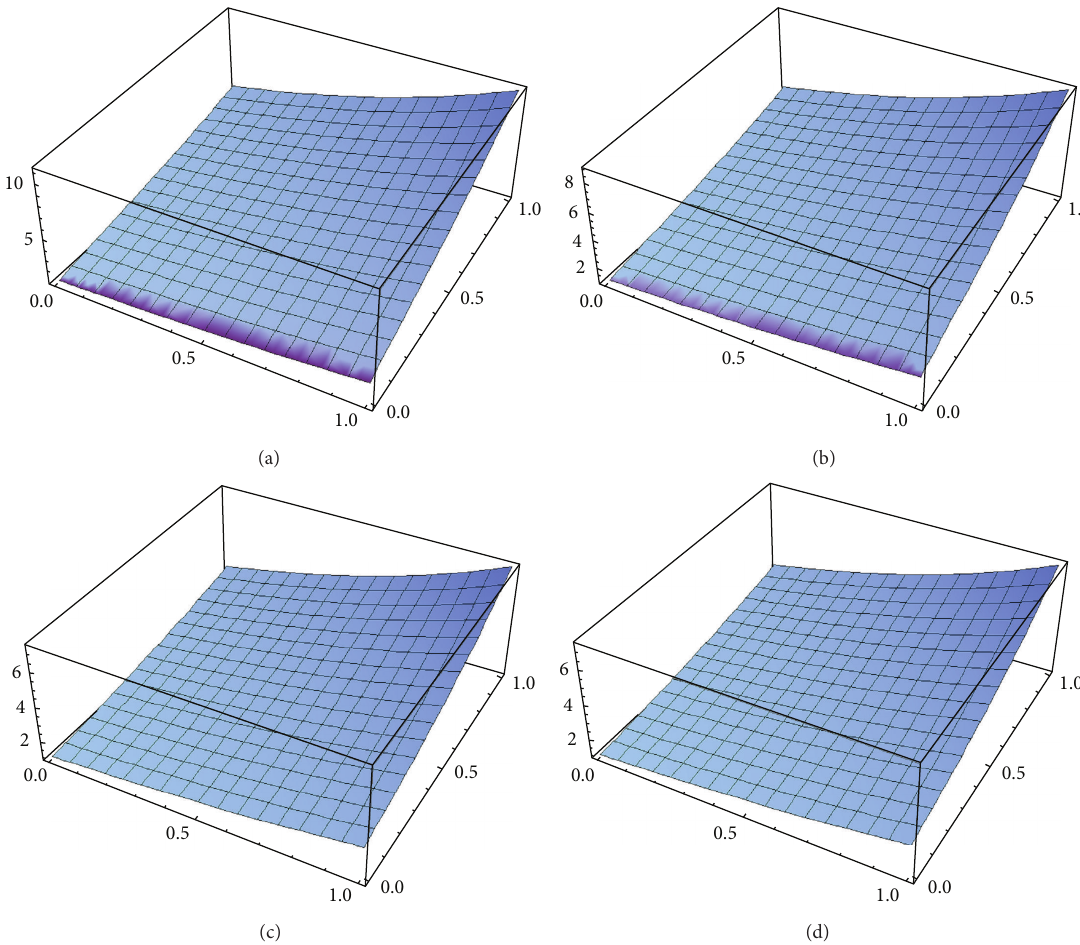
Figure 2: (a) 5-term approximate solution for 𝑢(𝑥,𝑡) and V (𝑥,𝑡) , in case 𝑥 : 0 → 1 , 𝑡 : 0 → 1 , and 𝛼 = 0.6 . (b) 5-term approximate solution for 𝑢(𝑥,𝑡) and V (𝑥,𝑡) , in case 𝑥 : 0 → 1 , 𝑡 : 0 → 1 , and 𝛼 = 0.8 . (c) 5-term approximate solution for 𝑢(𝑥,𝑡) and V (𝑥,𝑡) , in case 𝑥 : 0 → 1 , 𝑡 : 0 → 1 , and 𝛼 = 1 . (d) Exact solution for 𝑢(𝑥, 𝑡) and V (𝑥,𝑡) , in case 𝑥 : 0 → 1 , 𝑡 : 0 → 1 , and 𝛼 = 1